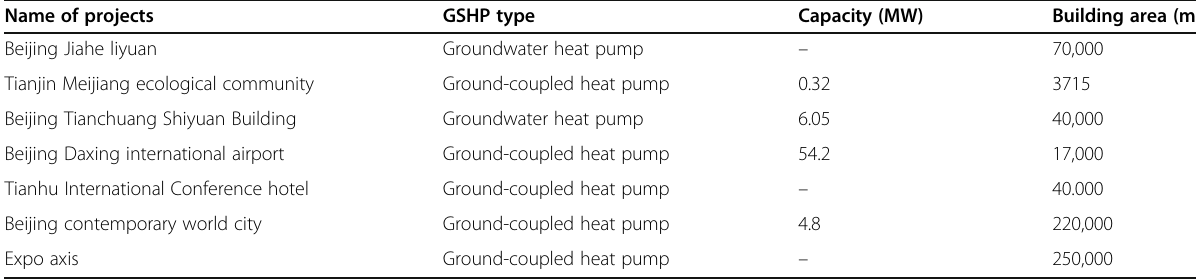
Table 1 Features of typical engineering projects Name of